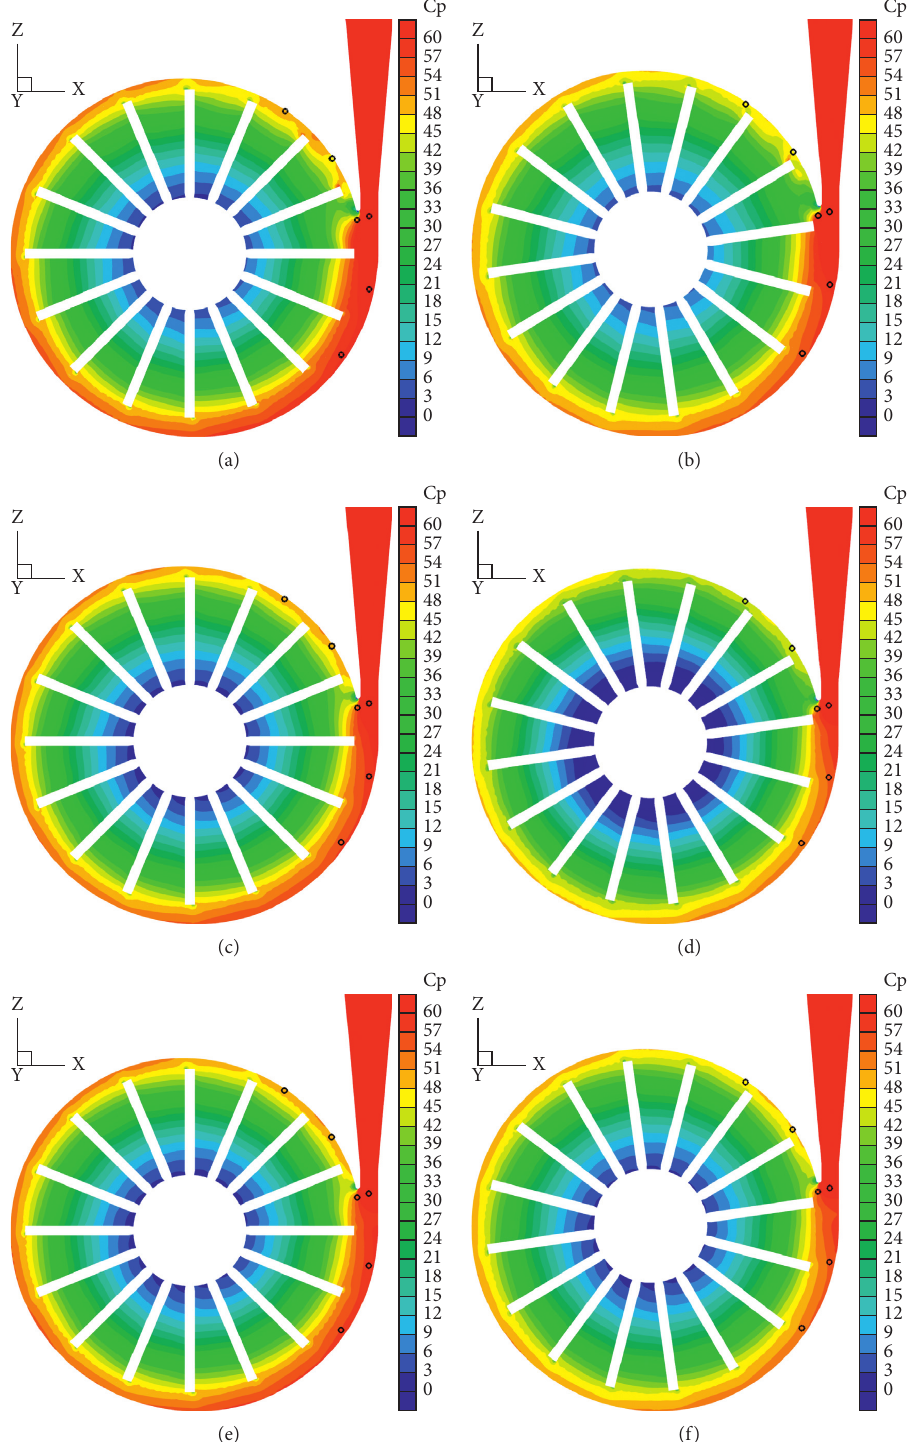
Figure 5: Distribution of static pressure in the central section of impeller under different flow rates: (a) 0.2 Q atpressurepulsationvalley;(c)1.0 Q d ,atpressurepulsationpeak;(d)1.0 Q d ,atpressurepulsationvalley;(e)1.4 Q d ,atpressurepulsationpeak;and(f) 1.4 Q d , at pressure pulsation